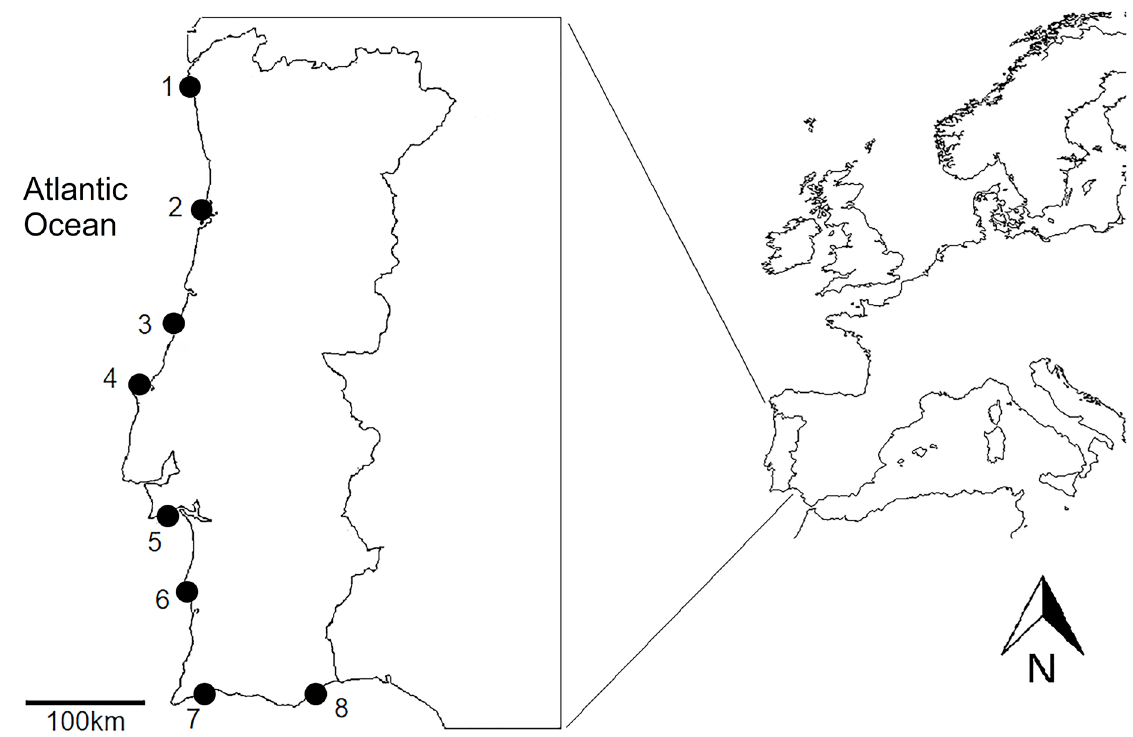
Fig. 1. Localities of the sampling sites along the Portuguese coast. 1. Afife Beach, 2. Torreira Beach. 3. Vieira Beach. 4. Baleal Sul Beach. 5. Portinho da Arrábida Beach. 6. Vasco da gama Beach. 7. Meia- Praia Beach. 8. Ilha de Tavira